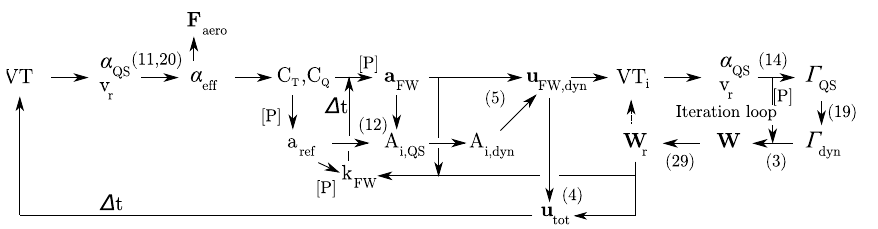
Figure 3. Overview of one time step in the coupled near- and far-wake model used in this work. Relevant equation numbers are included. [P] refers to Pirrung et al.